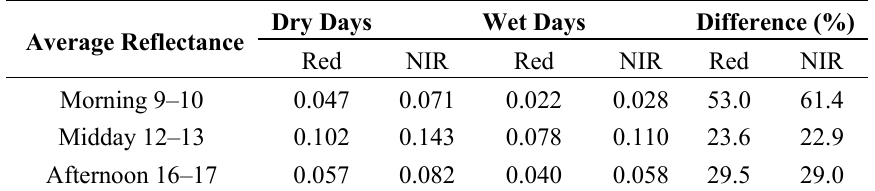
Table 3. Time of day specific averages of Red and Near Infrared (NIR) reflectance for dry and wet days respectively during the 2006 bare soil period.